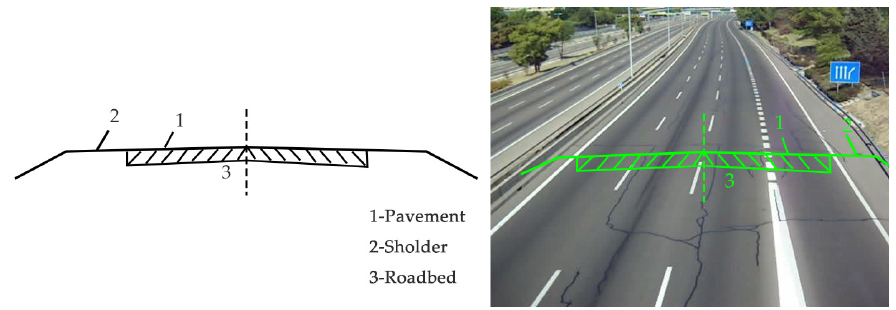
Figure 11. Composition of a